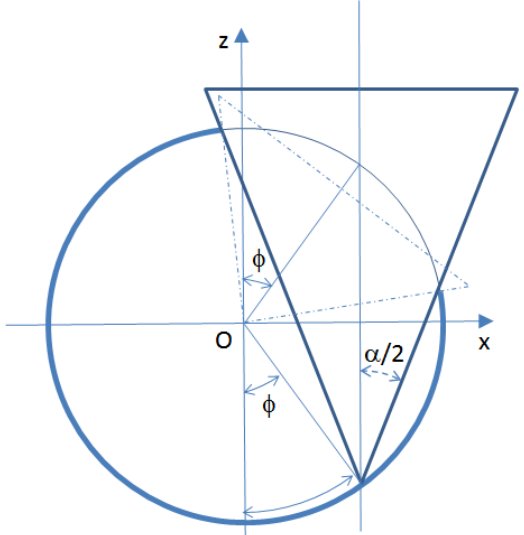
Figure 4: HCM for the generic off-center crack